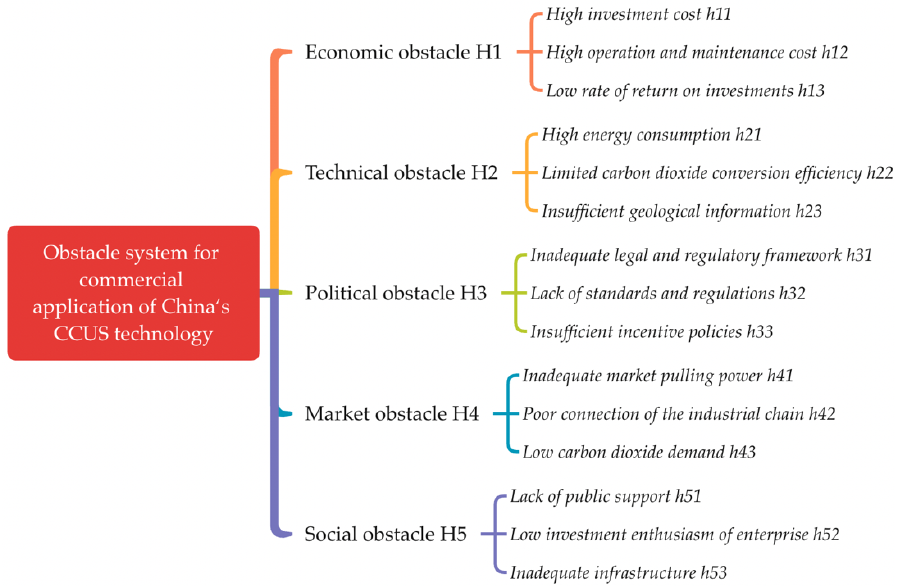
Figure 1. Obstacle system for China’s CCUS technology commercialization .